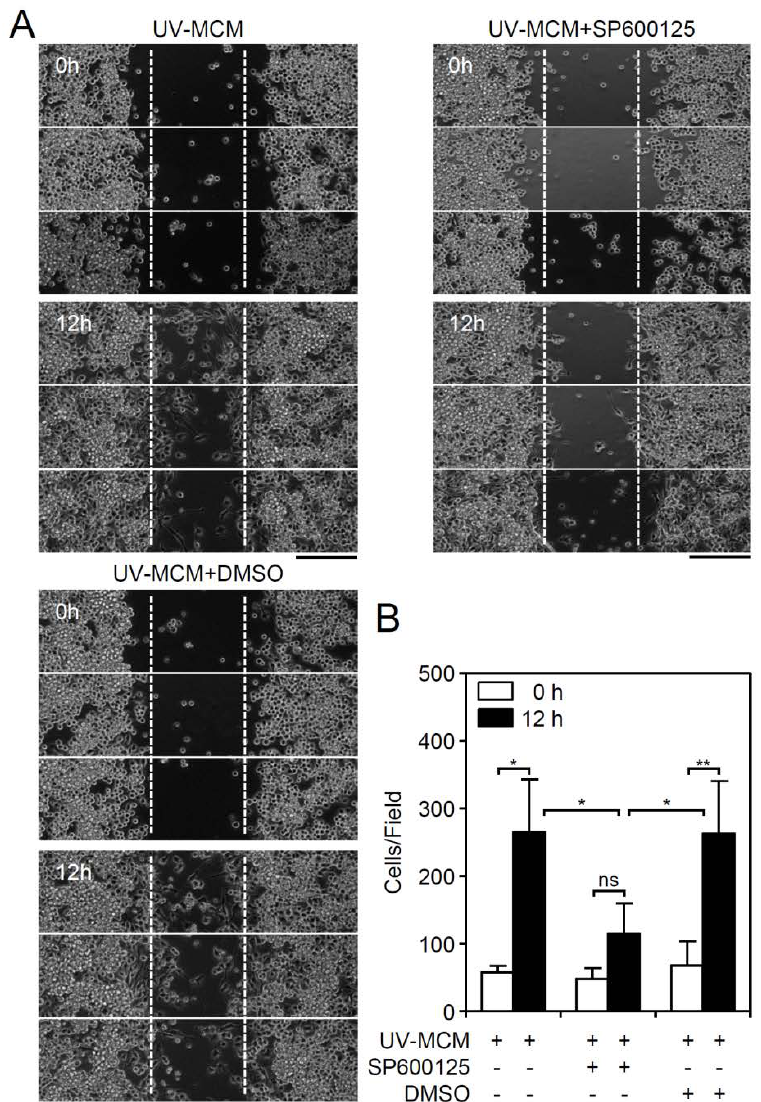
Figure 4. Pharmacological inhibition of JNK reduces DENV-induced BV2 microglial cell migration. Migration in UV-MCM-stimulated BV2 cells incubated with or without a JNK inhibitor (SP600125, 20 µ M) treatment was measured by the wound-healing assay 12 h post-infection. ( A ) The wound-healing assay and ( B ) the measurement of the migrating cell number showed cell migration. Dimethyl sulfoxide (DMSO) as a solvent control. Scale bar, 200 µ m. All quantitative data are shown as the means ± SD from three independent experiments. * p < 0.05 and ** p < 0.01. ns, not significant.